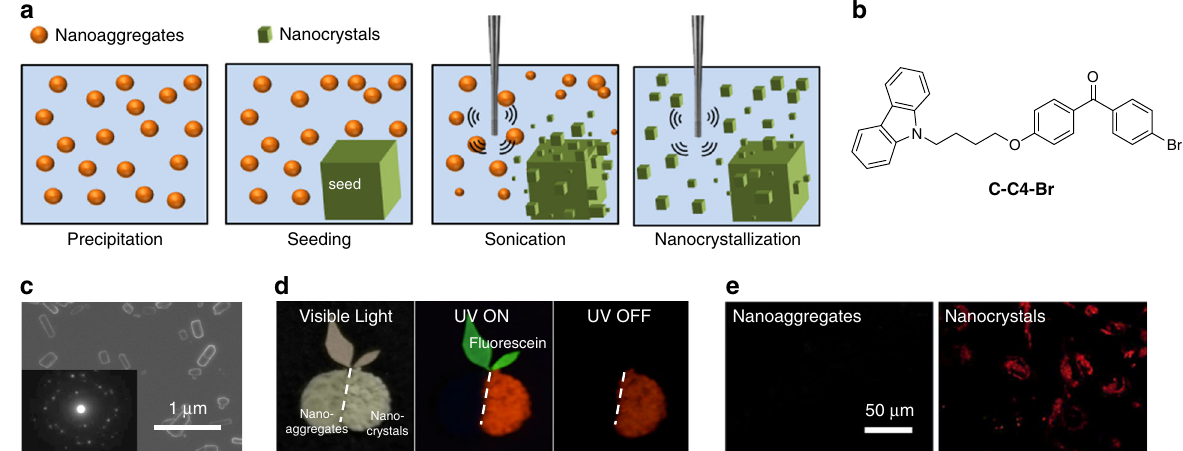
Fig. 5 Nanocrystallization of amorphous nanoaggregates to yield organic RTP contrast agents for bioimaging. a Schematic illustration of the seed-assisted nanocrystallization process. b Chemical structure of C-C4-Br with red persistent RTP. c Scanning electron microscopy image of the C-C4-Br nanocrystals. Inset shows the selected area electron diffraction pattern of the nanocrystals. d Photoluminescence of the C-C4-Br amorphous nanoaggregates and nanocrystals (both in orange) and fl uorescein (green) under various illumination states. e Confocal laser scanning microscopy images of breast cancer cells treated with amorphous nanoaggregates (left) and nanocrystals (right) of C-C4-Br . a is adapted with permission from ref. 85 . Copyright (2017) Wiley-VCH Verlag GmbH & Co. b , c , d , and e are adapted with permission from ref. 57 . Copyright (2017) Wiley-VCH Verlag GmbH &